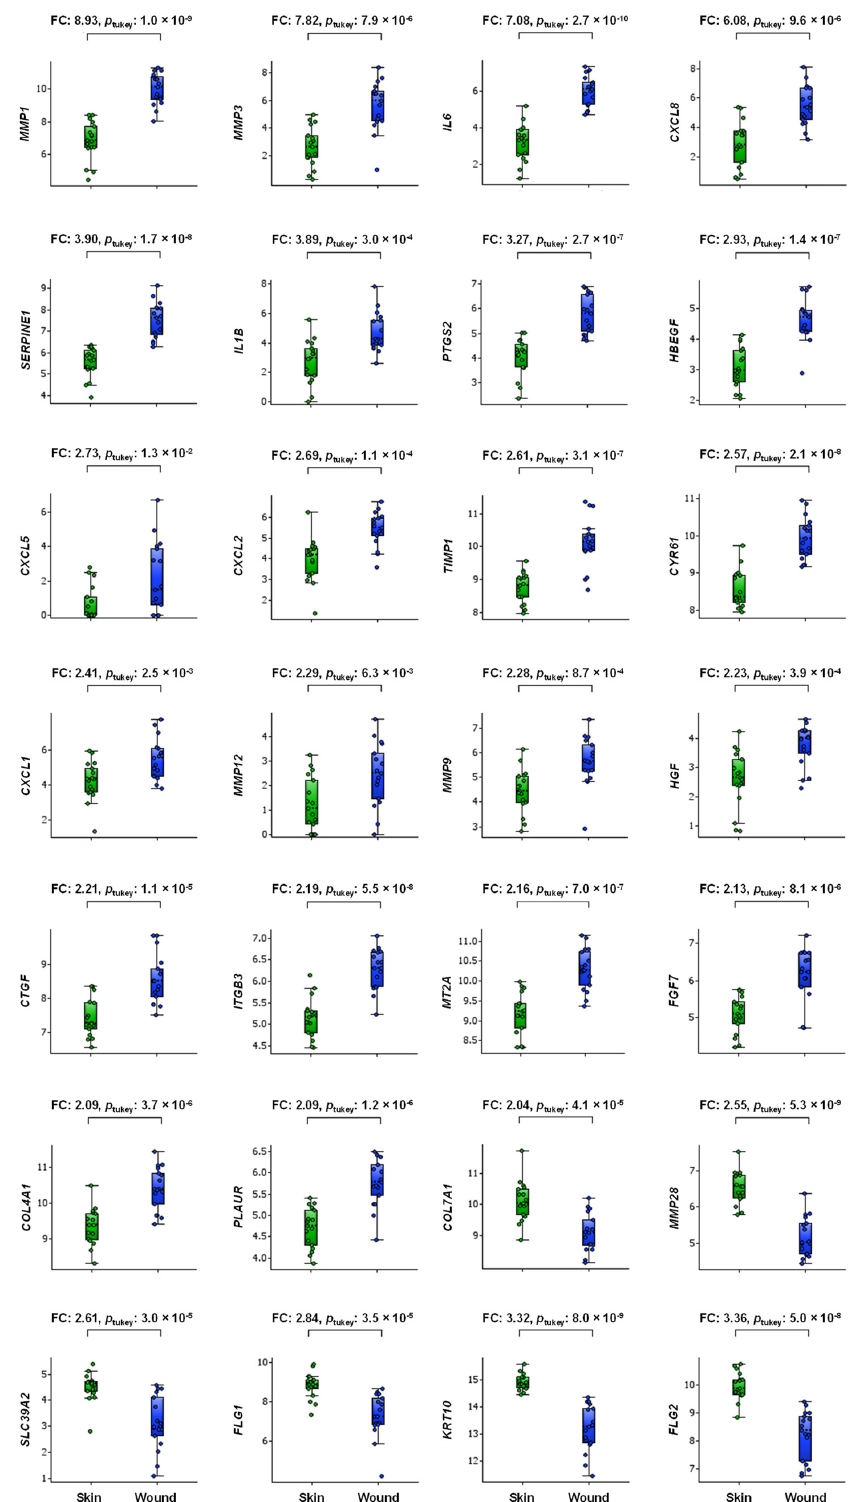
Figure 1. Box plot of injury-induced DEGs in wound tissue (blue symbols) vs. adjacent normal skin (green symbols) tissue of 4-day-old deroofed suction blisters ( n = 17) arranged in descending FC order. Boxes represent the 25th–75th percentiles, whiskers represent the 5th–95th percentiles, and the horizontal dashed lines within the boxes indicate the median values. The y-axis shows log2-transformed expression values. FC, fold change.